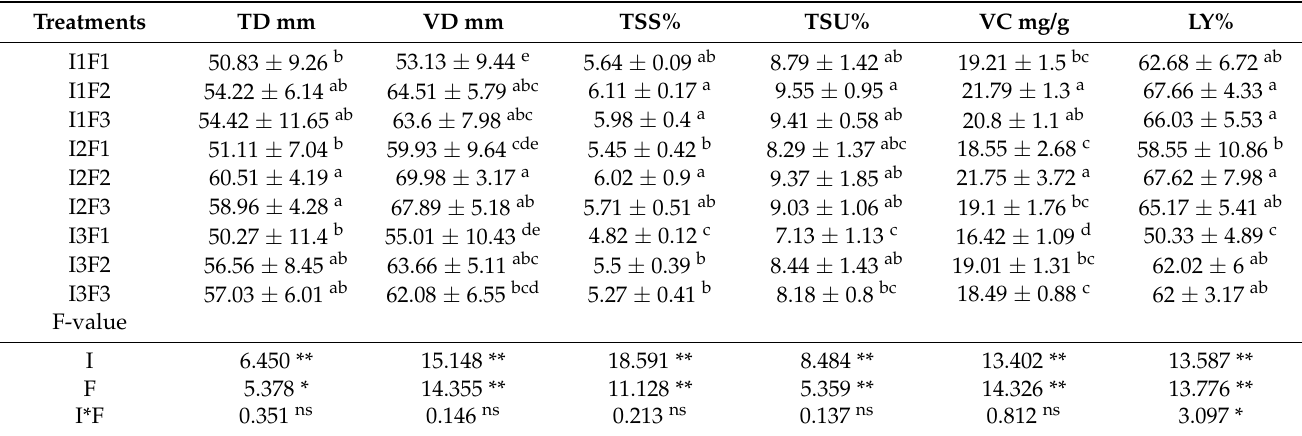
Table 5. Effect of integrated water and fertilizer on the quality of tomato fruit by moistube irrigation in greenhouse.